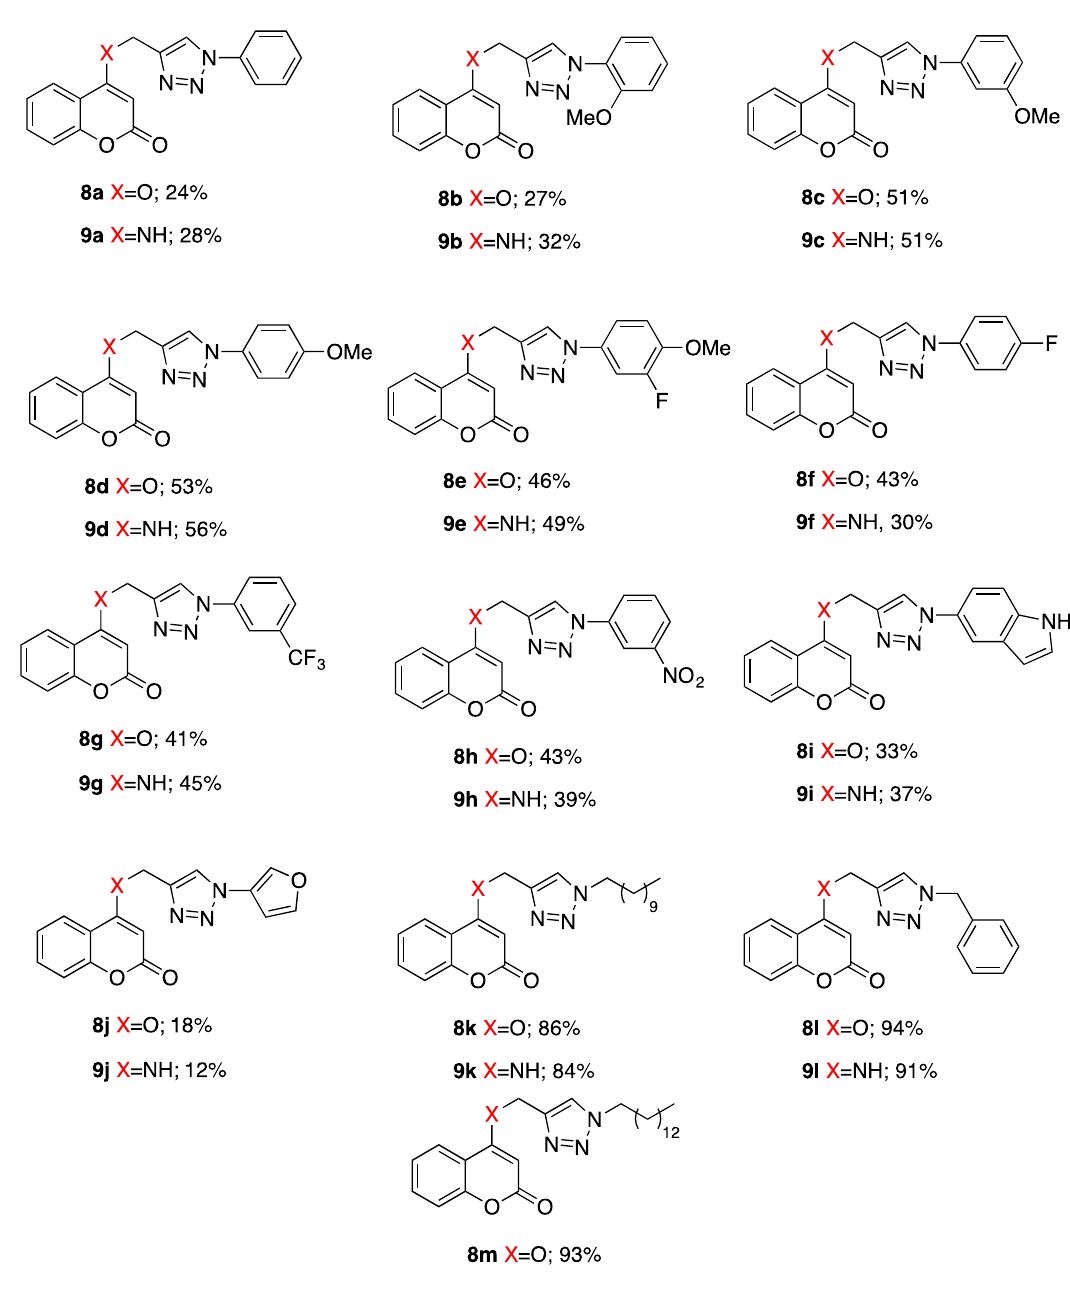
Figure 1. Structures of 4-substituted 1,2,3-triazole-coumarin derivatives ( 8a – 8n ) and ( 9a – 9n ).